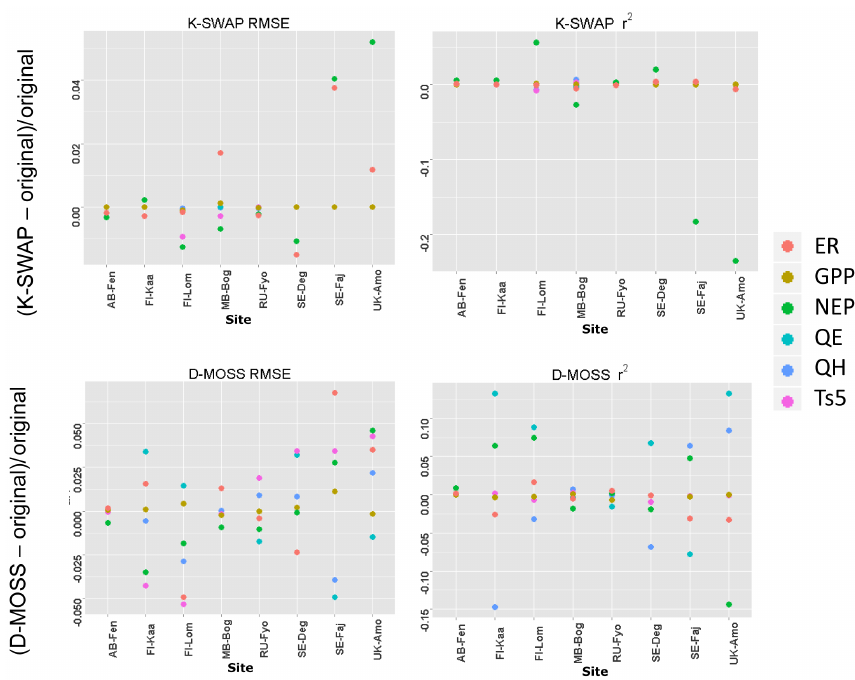
Figure 18. Comparisons of RMSE and r 2 of the simulated latent heat flux (QE), sensible heat flux (QH), soil temperature at 5cm depth ( T s5 ), GPP, ER, and NEP against the original simulations for the two tests described in Sect.